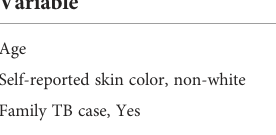
TABLE 3 Characteristics associated with QFT-GIT positivity among study population.